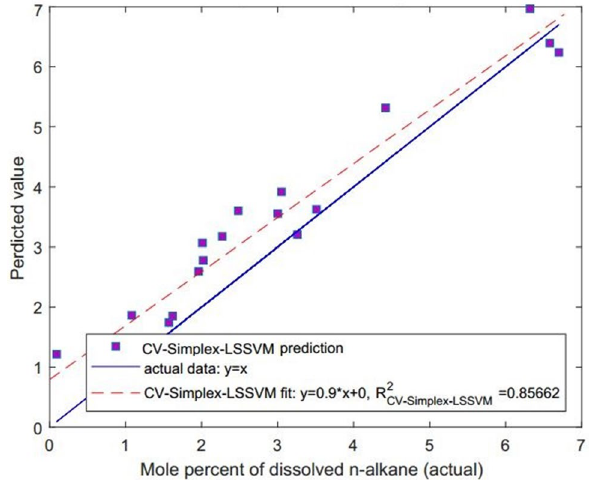
Fig. 5 CV-Simplex–LSSVM predicted dissolved mole percent of n -alkane for testing dataset